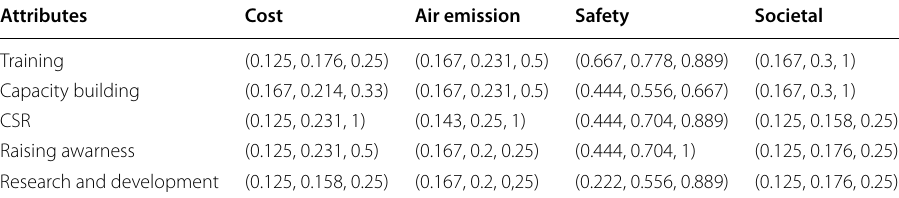
Table 17 Fuzzy decision matrix Attributes